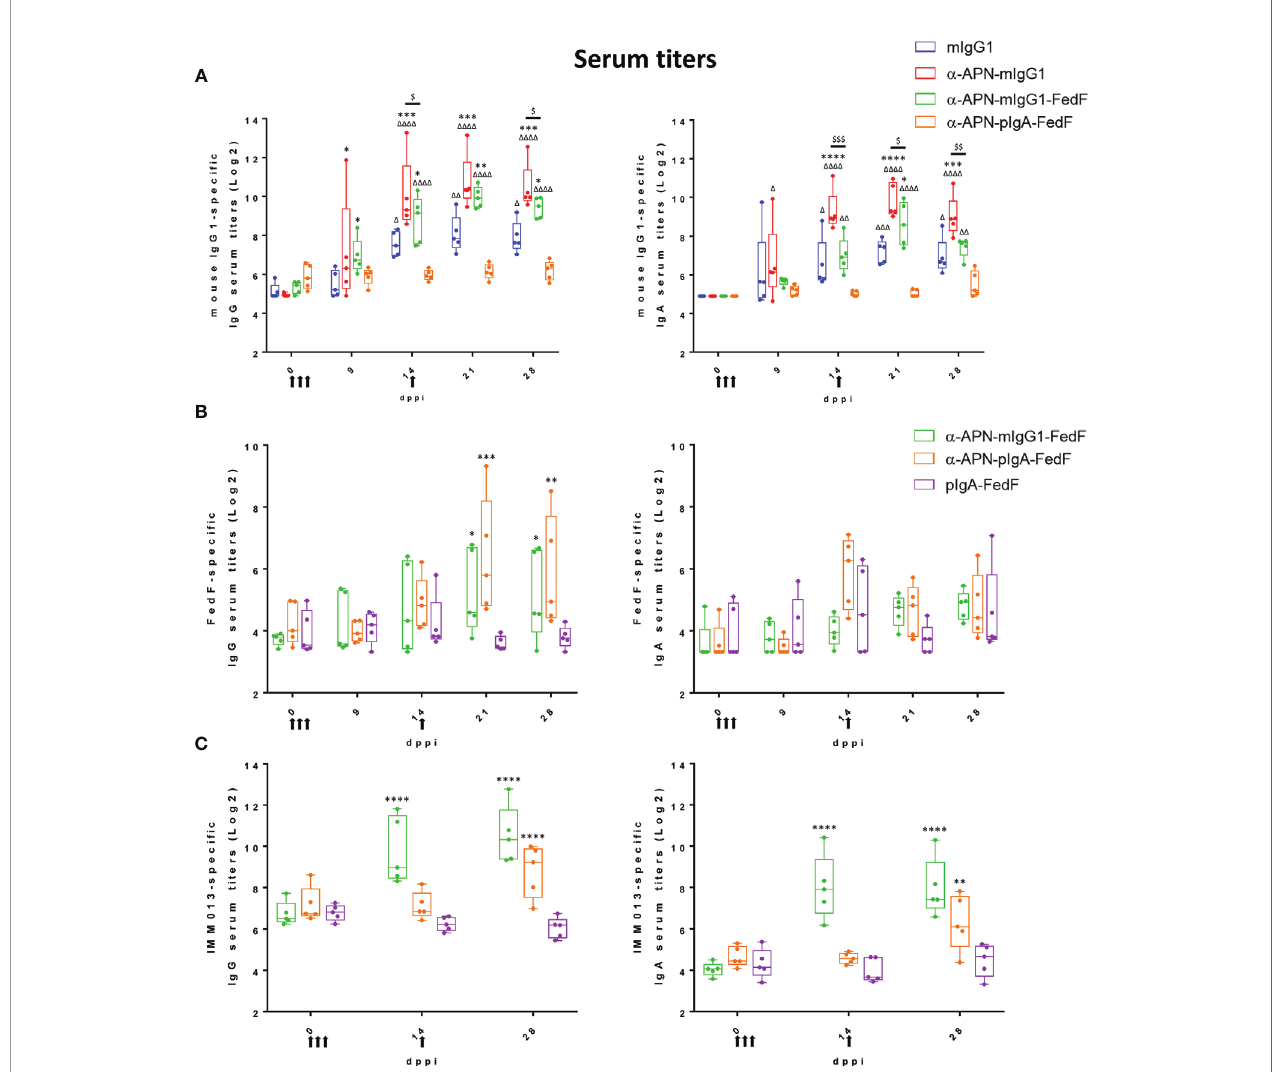
FIGURE 6 | Increased serum responses after oral immunization with APN-speci fi c antibody constructs. (A) mIgG1-speci fi c, (B) FedF-speci fi c and (C) IMM013- speci fi c IgG (left) and IgA (right) serum titers 0, 9, 14, 21 and 28 dppi (days post primary immunization). OD: optical density. Arrows indicate days of immunization. Multiplicity adjusted p-values: * , D ,$ p < .05; ** , DD ,$$ p < .01; *** , DDD ,$$$ p < .001; **** , DDDD p < .0001; * indicates signi fi cant differences compared to (A) mIgG1 isotype ctrl or (B, C) pIgA-FedF ctrl; (A) D indicates signi fi cant differences compared to pIgA-FedF ctrl; $ indicates signi fi cant differences between a -APN-mIgG1 and a -APN- mIgG1-FedF. n=5. mIgG1, mouse IgG1; pIgA, pig